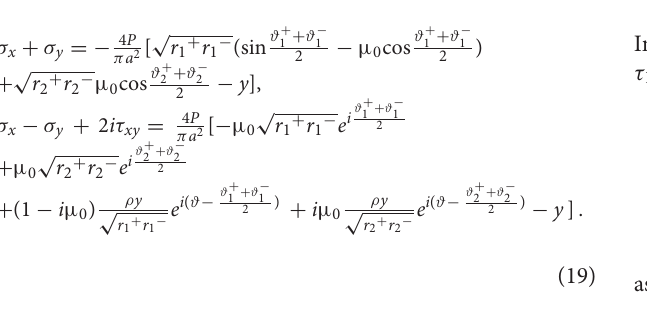
q ( x ) contact tractions ( µ 0 ¯